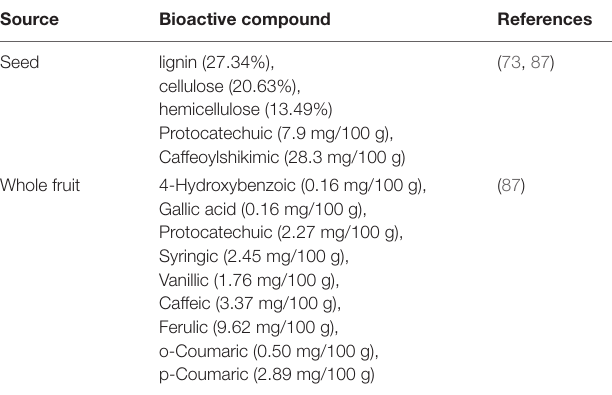
TABLE 3 | Different bioactive compounds reported in seed and whole fruit of the